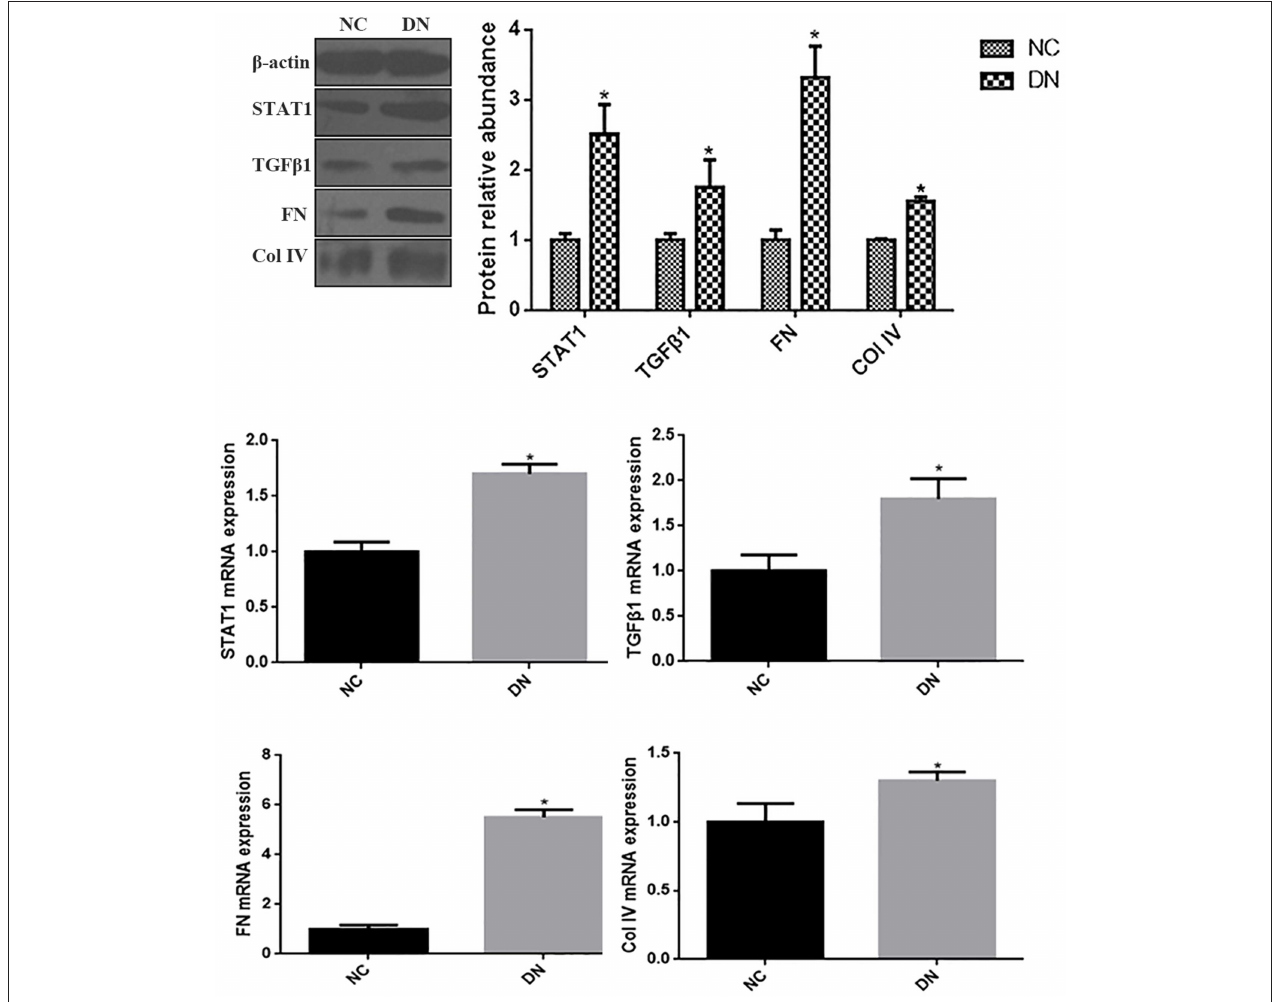
FIGURE 1 | The expressions of STAT1, TGF β 1, FN, and Col IV in non-diabetic adjacent normal kidney tissues (NC), and renal biopsy sections from DN patients. (A) Protein expression levels of STAT1, TGF β 1, FN, and Col IV were quantified by western blot analysis. (B) mRNA expressions levels of STAT1, TGF β 1, FN, and Col IV were quantified by qRT-PCR. * P < 0.05 vs.